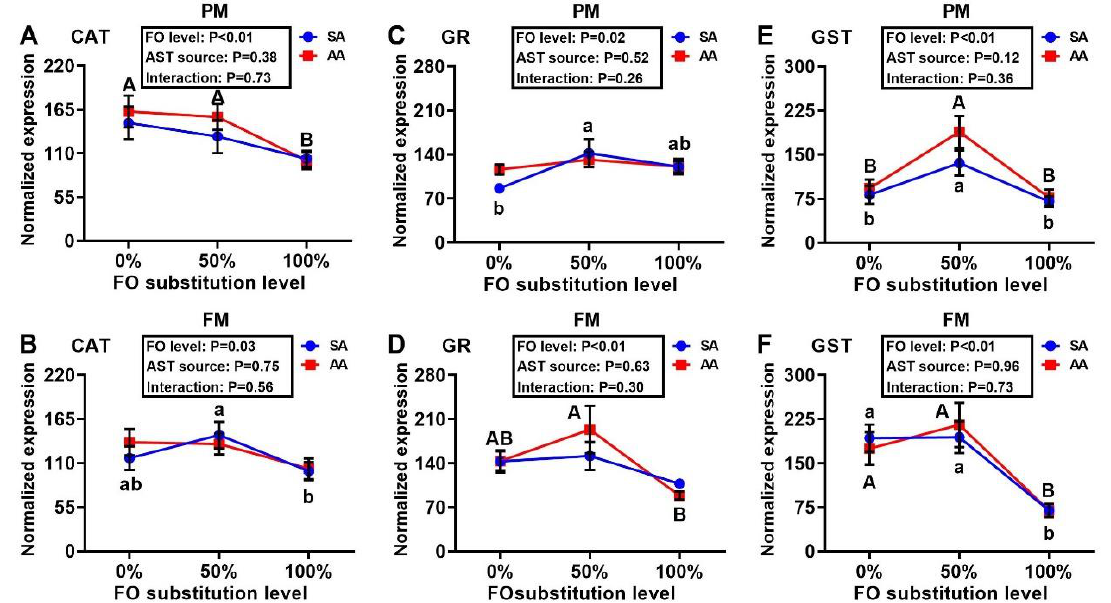
Figure 7. Effects of dietary fish oil substitution by DHA-rich microalgae and source of astaxanthin on hepatic mRNA levels of CAT ( A , B ), GR ( C , D ), and GST ( E , F ) of juvenile rainbow trout fed the plant meal- (PM, A , C , E ) and fishmeal (FM, B , D , F )-based diets. Means labelled with different letters [lowercase (a, b), synthetic astaxanthin (SA) groups; uppercase (A, B), microalgae astaxanthin (AA) groups] are different between various fish oil substitutions ( p < 0.05). The absence of different letters (a, b or A, B) between means indicates no significant differences. CAT: catalase; GR: glutathione reductase; GST: glutathione S-transferase. FO: fish oil. AST: astaxanthin.